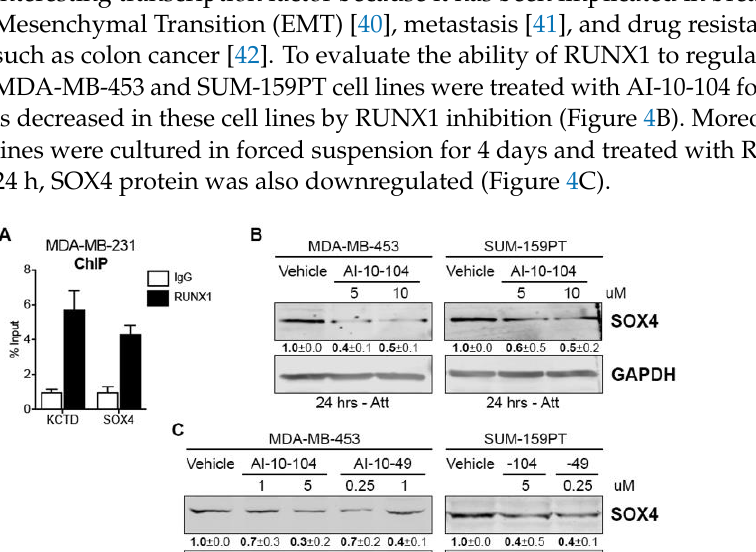
Figure 4. RUNX1 binds to the SOX4 promoter and regulates its expression ( A ) RUNX1 ChIP assay was performed in MDA-MB-231 and SOX4 promoter primers were designed to determine RUNX1 binding by qPCR. KCTD was used as a positive control. ( B ) SOX4 Western blot was performed in MDA-MB-453 and SUM-159PT cultured in attached (Att) conditions and treated with AI-10-104 (5 or 10 µ M) for 24 h. GADPH was used as a housekeeping control. ( C ) MDA-MB-453 and SUM-159PT were cultured in forced-suspension (Sus) for 4 days and treated for one extra day with AI-10-104 (1 or 5 µ M) or AI-10-49 (0.25 or 1 µ M). GADPH was used as a housekeeping control. One representative experiment of three is shown in ( B , C ), mean ± SEM is indicated.